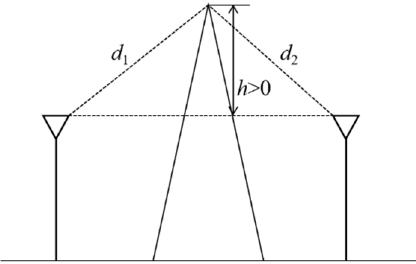
Figure 4. Parameters used in diffraction loss equation.